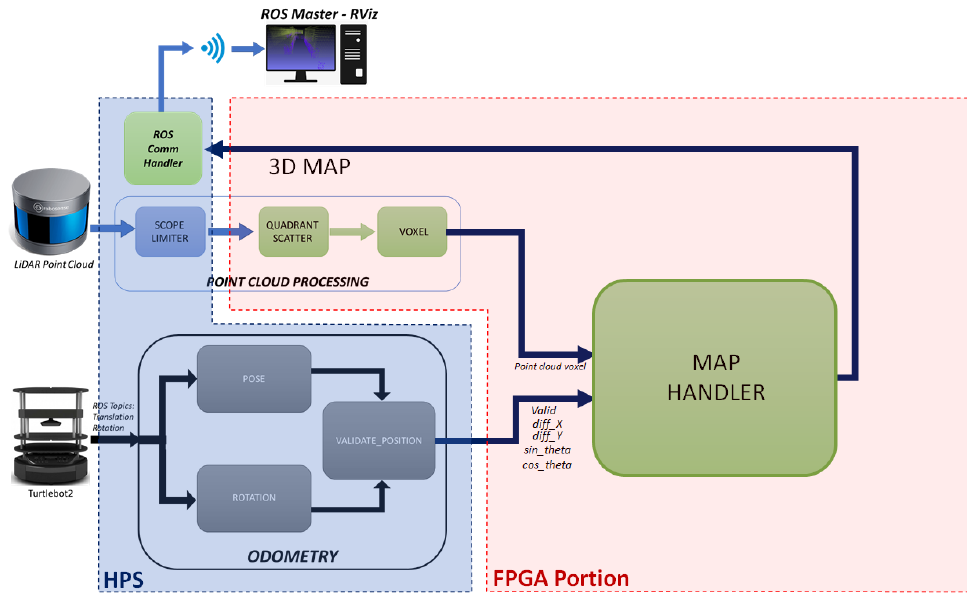
Figure 2. eSoC-LAM Architecture: Block